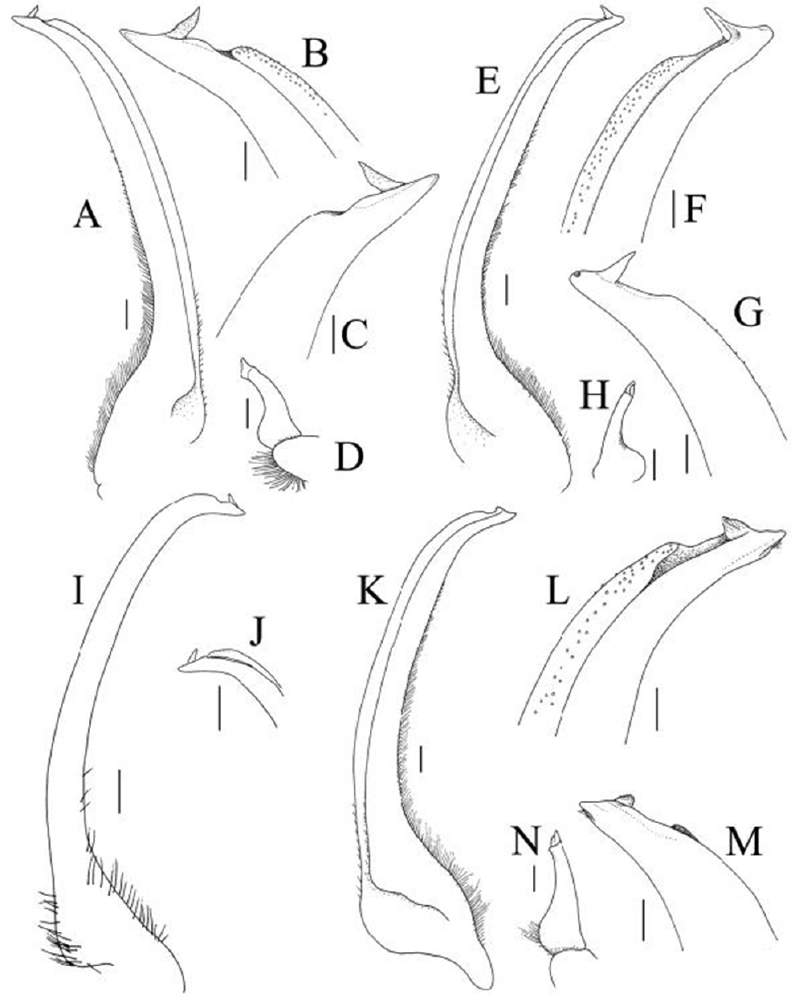
Figure 10. A–D Pleistacantha moseleyi (Miers, 1885), male (cl 82.5 mm, cw 61.6 mm) (ZRC 2005.117), Philippines E–H Pleistacantha pungens (Wood-Mason, in Wood-Mason & Alcock, 1891), male (cl 94.0 mm, cw 67.6 mm) (ZRC 2016.23), Myanmar I , J Pleistacantha ori Ahyong & Ng, 2007, holotype male (cl 146.0 mm, cw 106.3 mm) (ZRC 2006.0158), South Africa (after Ahyong & Ng 2007: fig. 4) K–N Pleistacantha kannu sp. n., holotype male (cl 106.2 mm, cw 87.0 mm) (CASAU), India. A–C, I, J right G1; D right G2; E–G, K–M left G1; H, N left G2. Scales: A, D, E, H, K, N 1.0 mm; B, C, F, G, L, M 0.5 mm; I, J 2.0